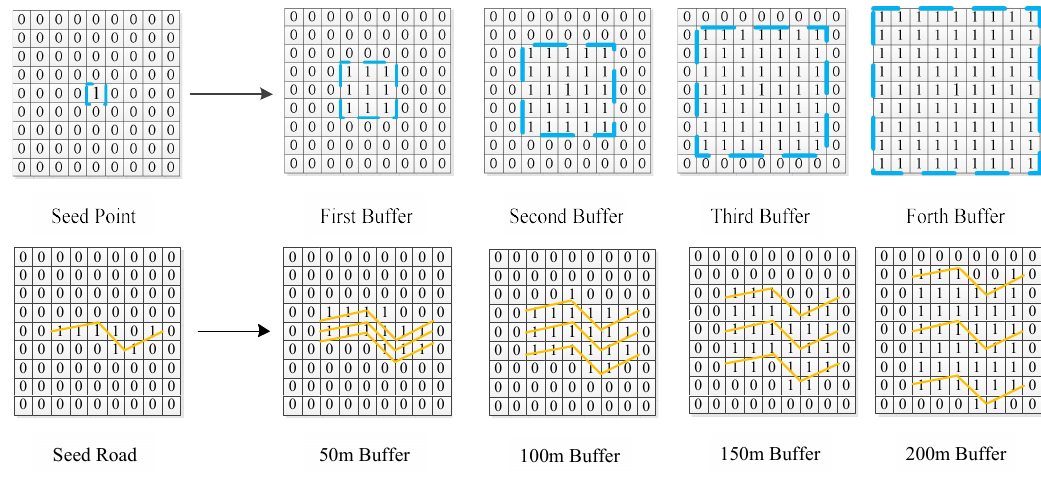
Figure 5. Multilayer Buffer Schematic.